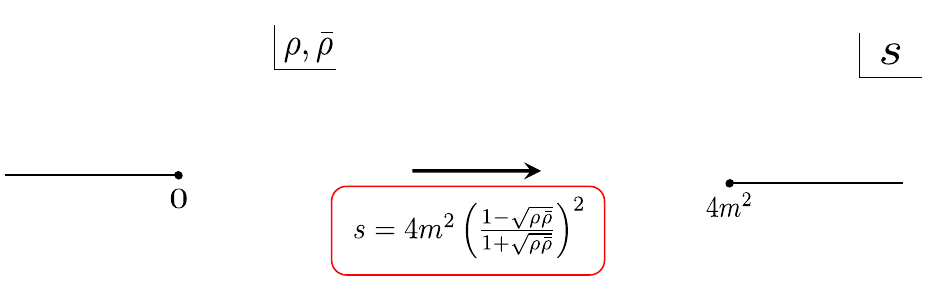
Figure 5. The analytic structure of the four-point function in CFT and the flat-space S-matrix. The conformal Mandelstam variables map the branch-cut singularities of the four-point function to a two-particle threshold of the